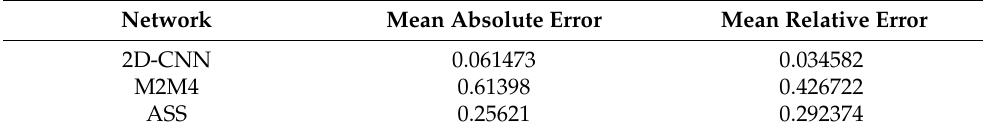
Table 2. Performance metrics of the three algorithms for SNR evaluation after dataset update.